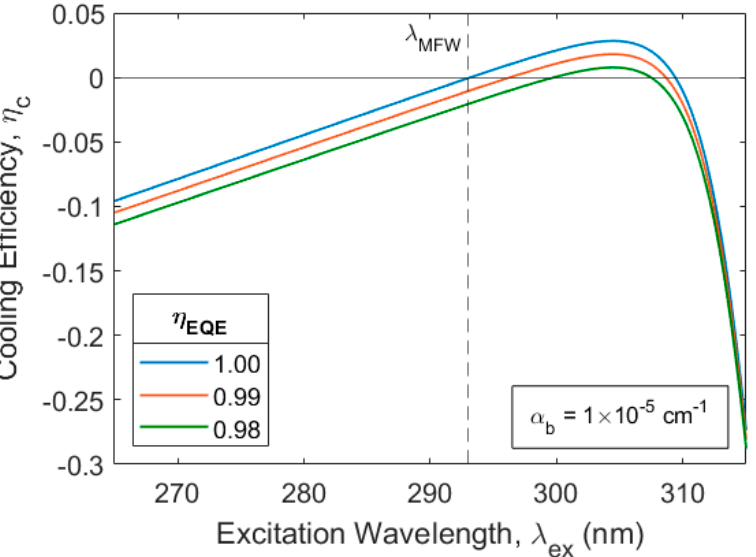
Figure 17. Plot of theoretical cooling efficiency versus pump wavelength of Ce 3+ ions in LiCaAlF 6 obtained from Equation (10) Cooling curves are shown for three different values of external quantum efficiency, assuming a background impurity absorption coefficient of α b = 1 × 10 − 5 cm − 1 . Peak cooling efficiency occurs at 305 nm but extends from 293–310 nm for unity quantum efficiency.